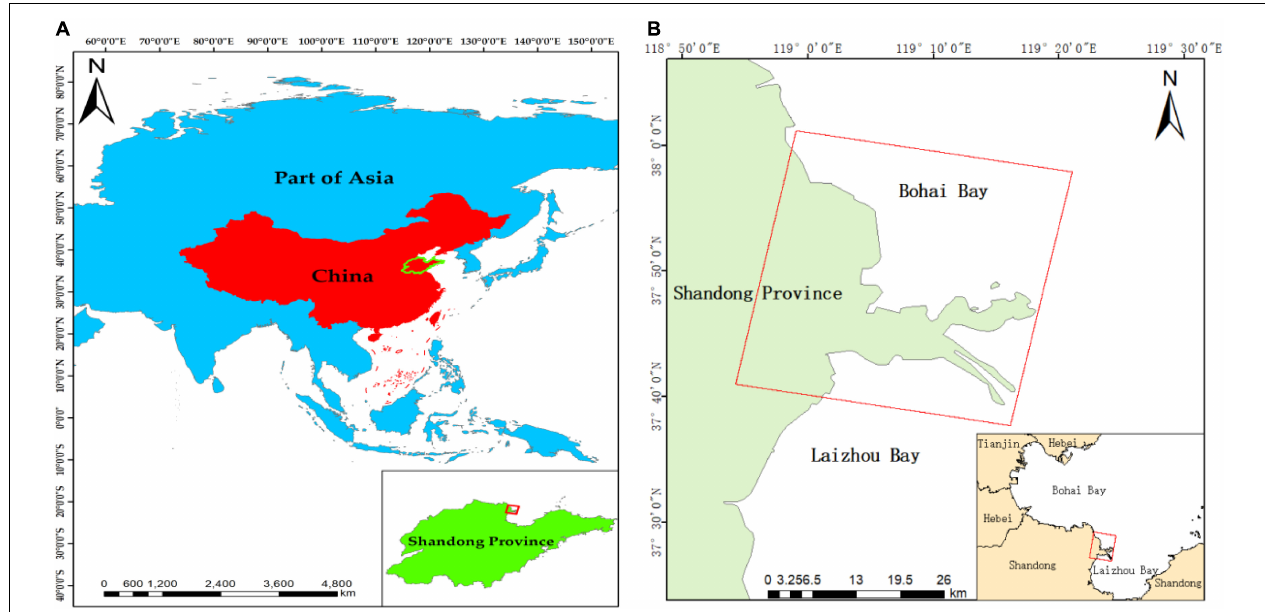
FIGURE 1 | Location of the study area, as indicated by the red square. (A) Asia with the study area location. The light blue represents parts of Asia. Red is China and the bright green part represents Shandong province in China. (B) The specific location of the study area in China.